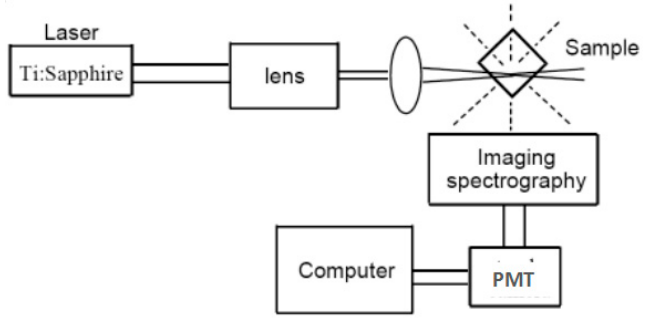
Figure 2. Experimental setup for two-photon fluorescence intensity at different excitation wavelengths.